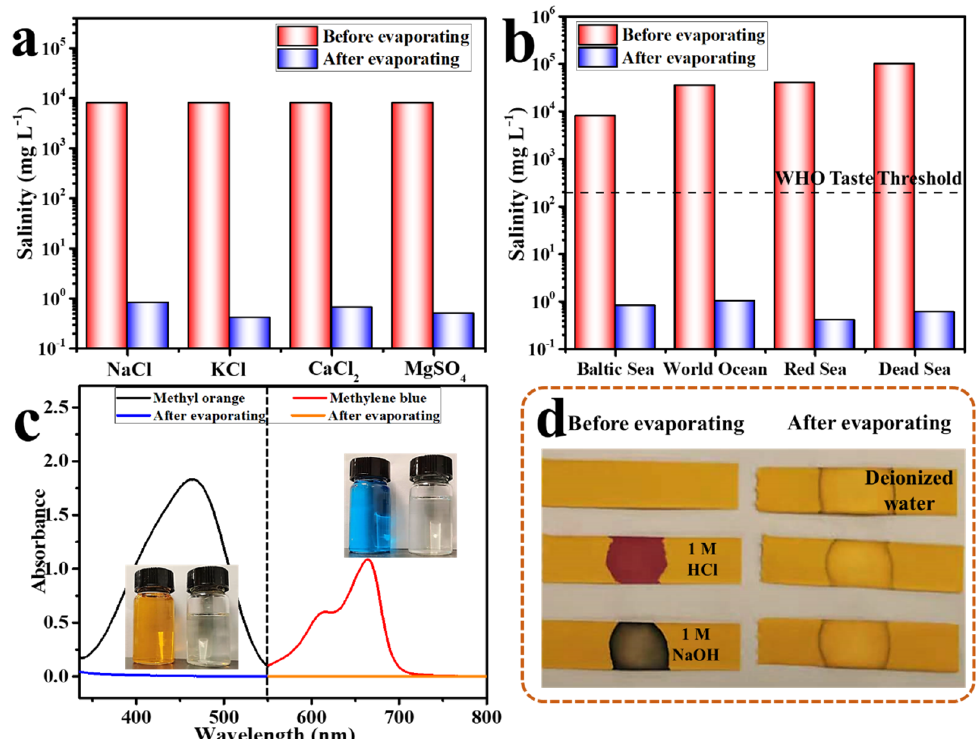
Figure 10. ( a ) Salinities of four simulated seawater samples before and after desalination; ( b ) digital images of MWCNTs@HPPS paper before and after desalination; ( c ) absorbance spectra of dyes solution and the condensed water after purification, the insets showed the corresponding optical images; ( d ) pH value of sewage before and after purification.